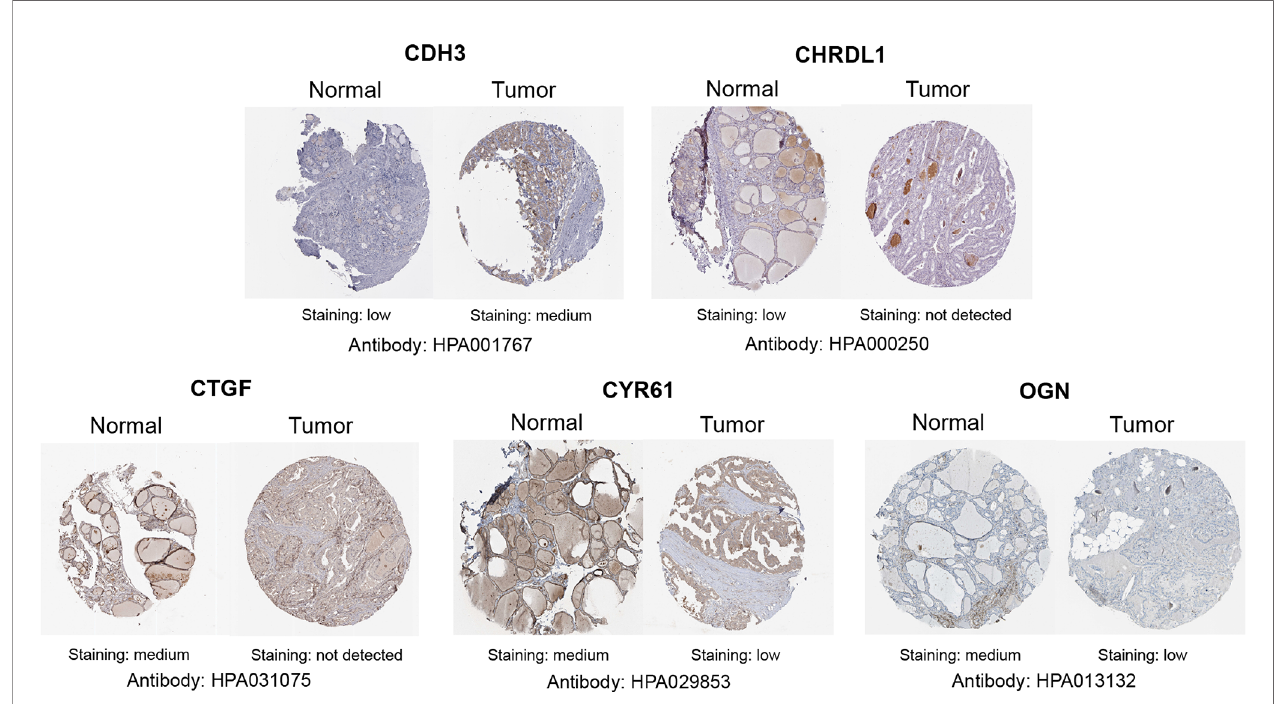
FIGURE 11 | Representative immunohistochemistry staining of screened genes. Protein expression levels of CDH3, CHRDL1, CTGF, CYR61, and OGN in PTC tissue obtained from the Human Protein